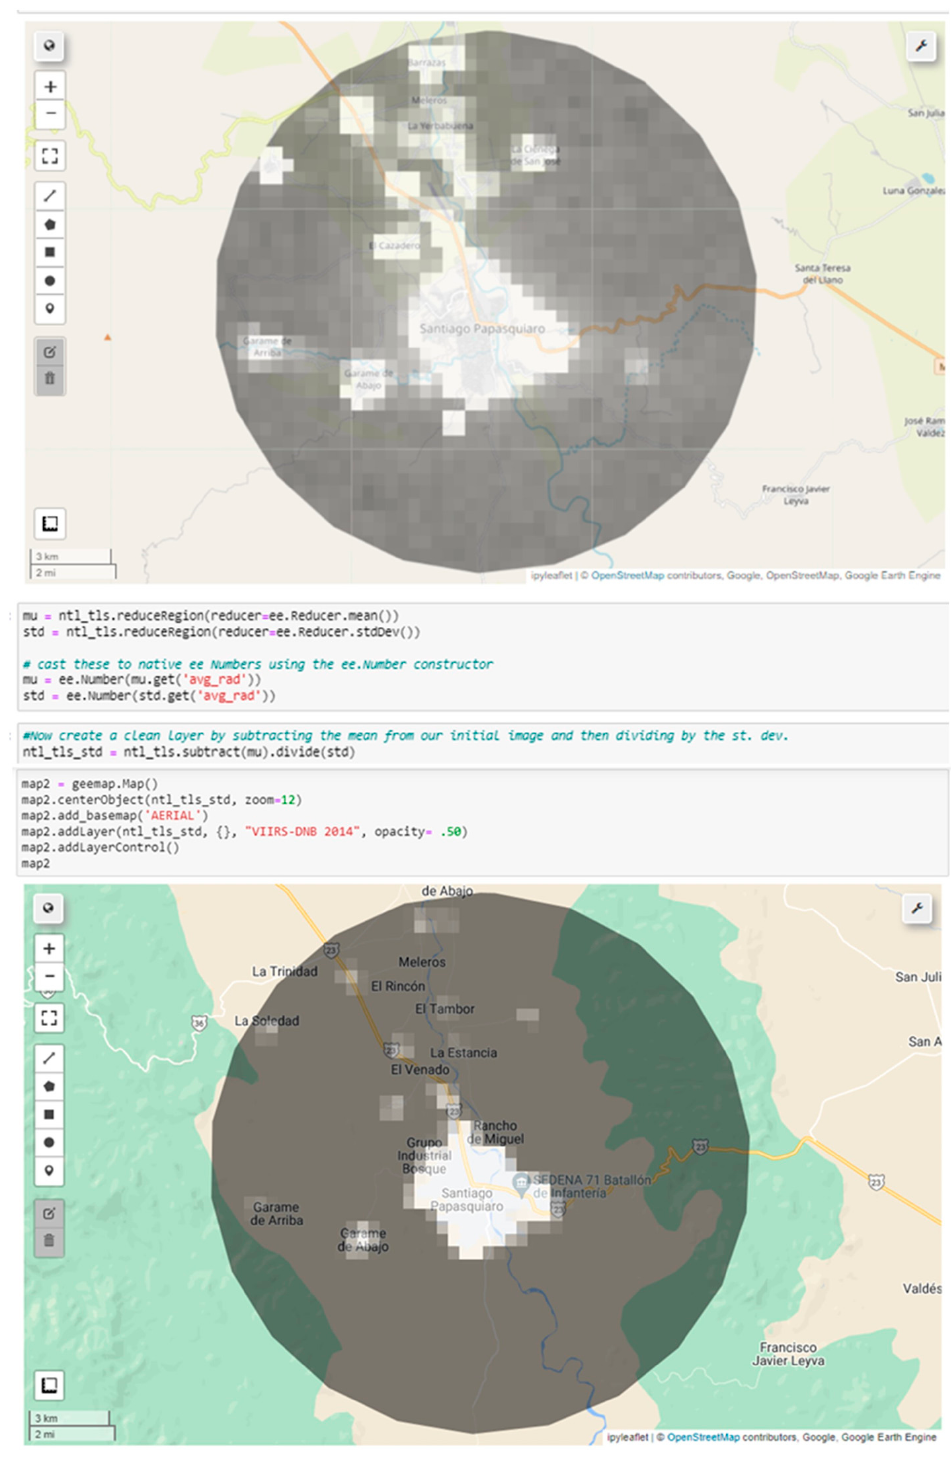
Figure 3. The impact of background noise removal.